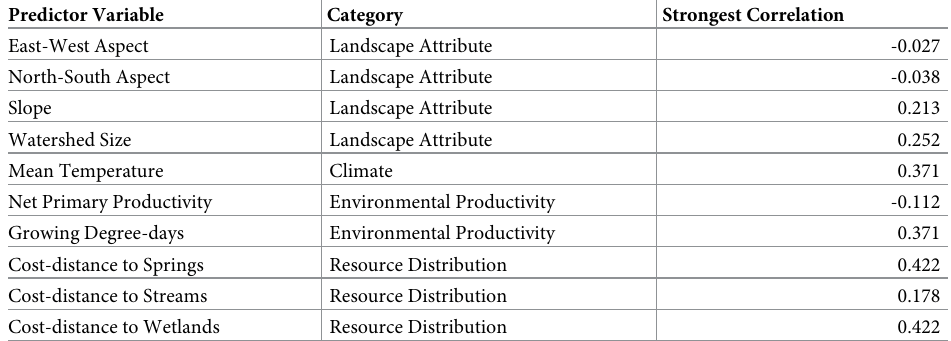
Table 1. Attributes of the ten predictor variables that have limited collinearity as identified by the PCA. See Sec. 10.1 in S1 File for more information on these